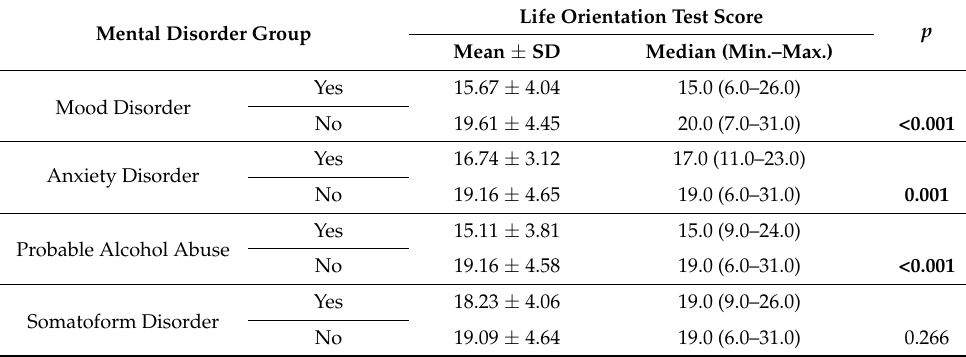
Table 2. The comparison of LOT scores in the study group based on the mental disorder diagnoses obtained from PRIME